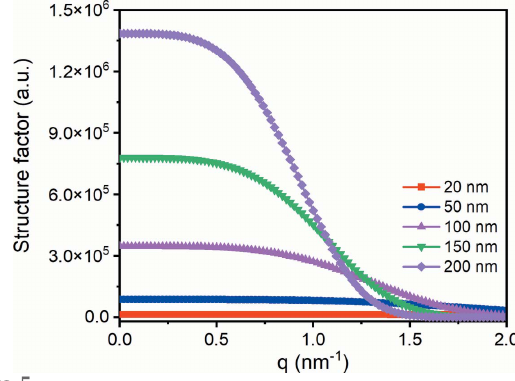
Figure 5 The change in form factor with the decrease in lateral